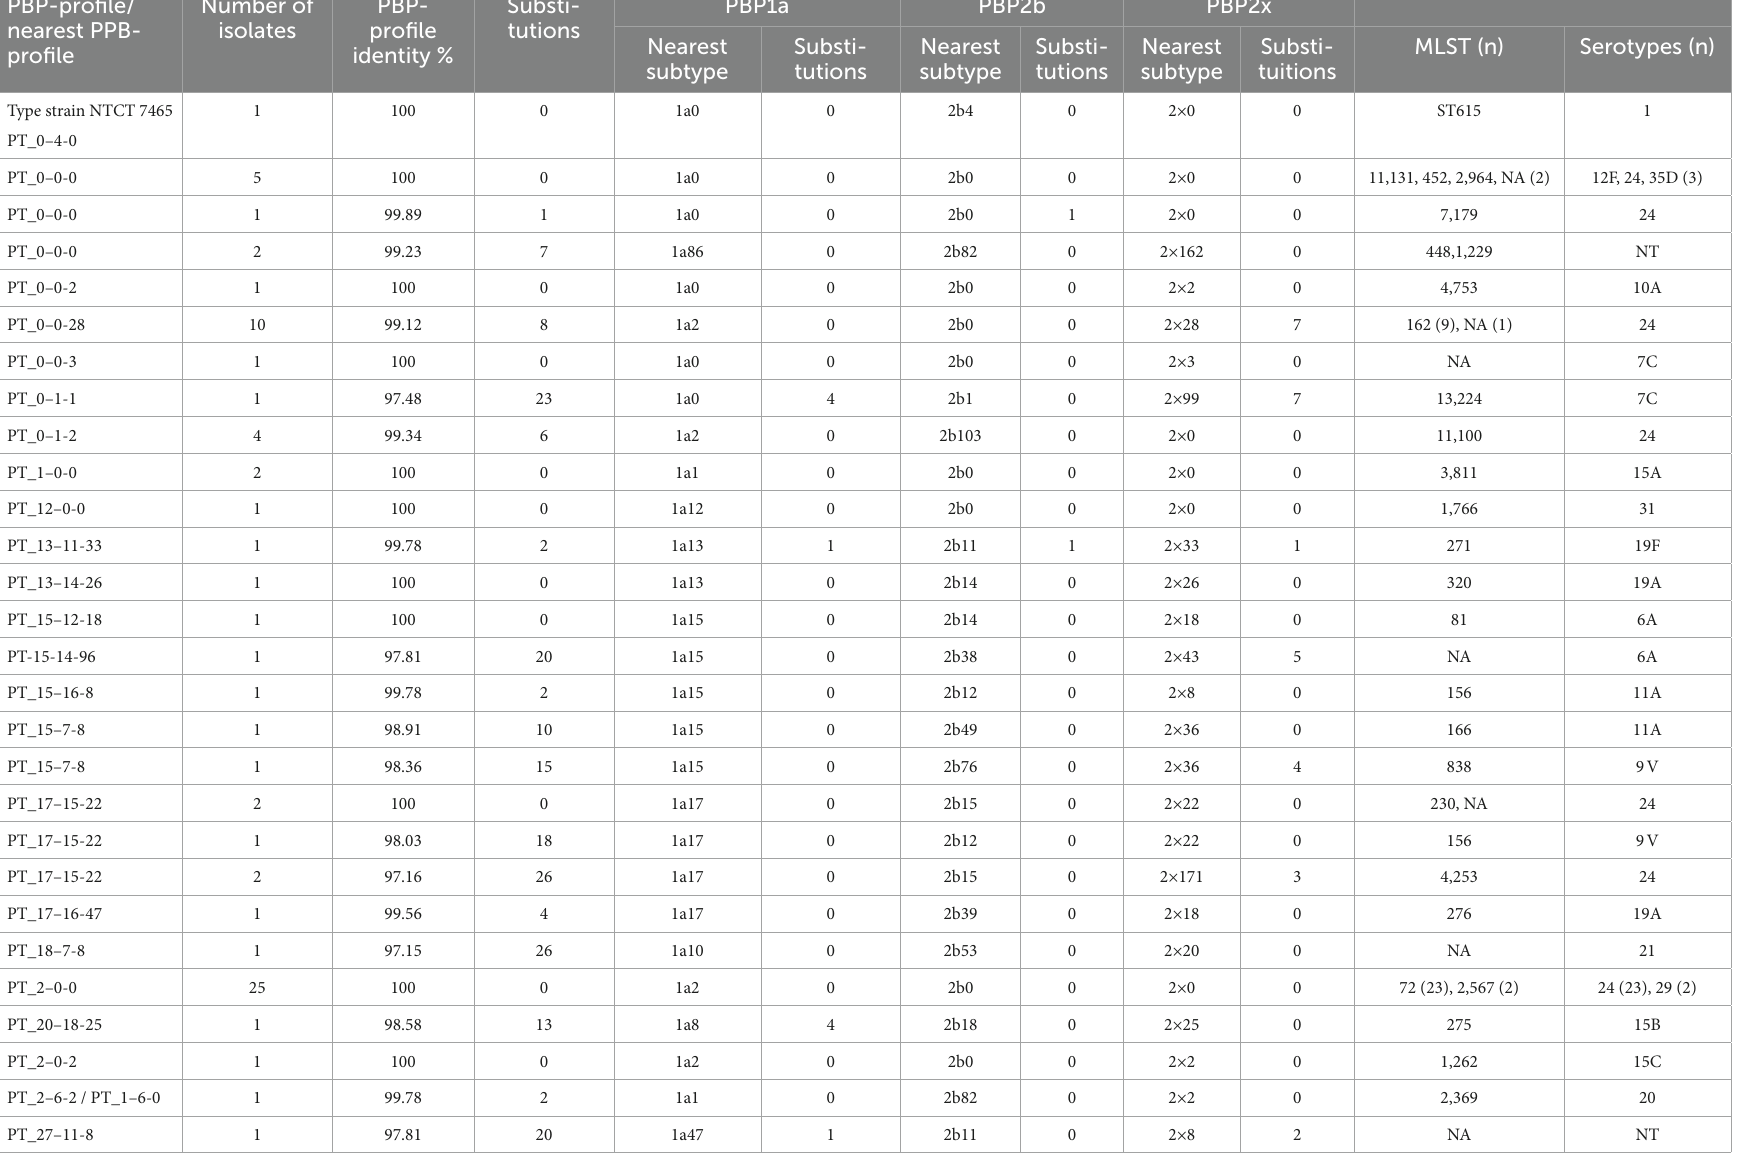
TABLE 1 Unique PBP-profiles and PBP1a-, PBP2b- and PBP2x-subtypes in Streptococcus pneumoniae and MLST and genomic